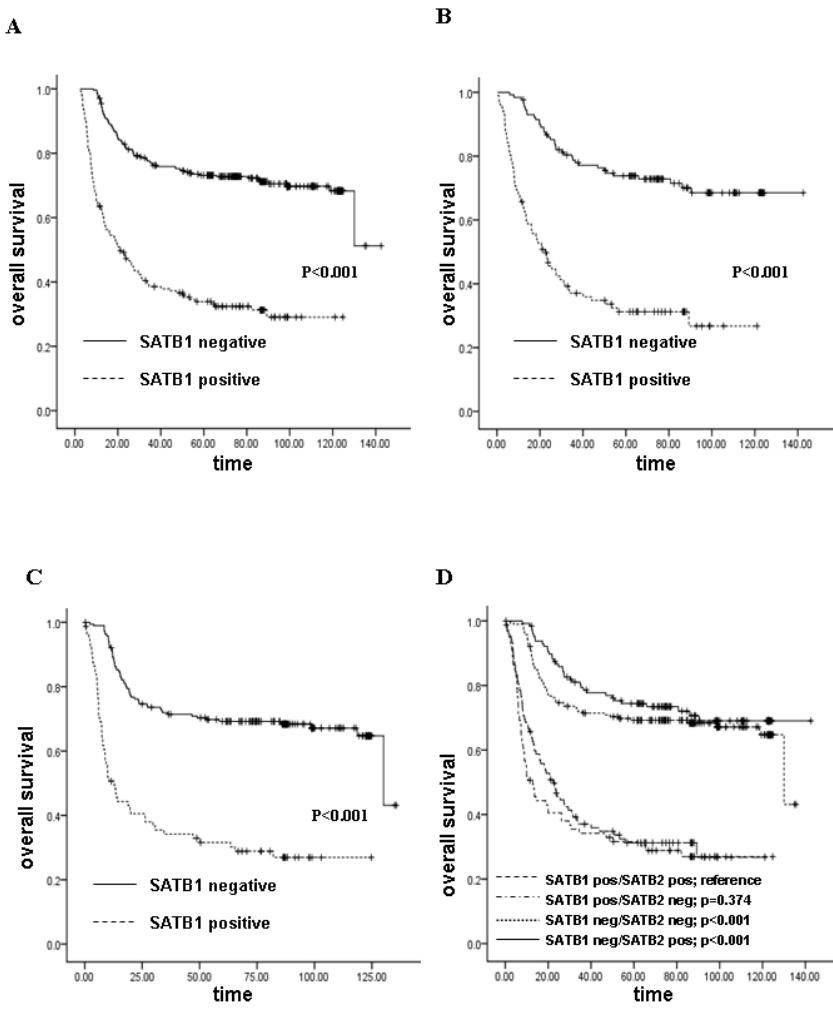
Figure 8. Kaplan-Meier estimates of the prognostic value of SATB1 expression. Kaplan-Meier survival analysis according to SATB1 expression in (A) all patients, (B) patients with SATB2 positive expression, (C) patients with SATB2 negative expression. (D) Kaplan-Meier estimates of colorectal cancer specific survival according to combinations of negative and positive SATB1 and SATB2 expression.